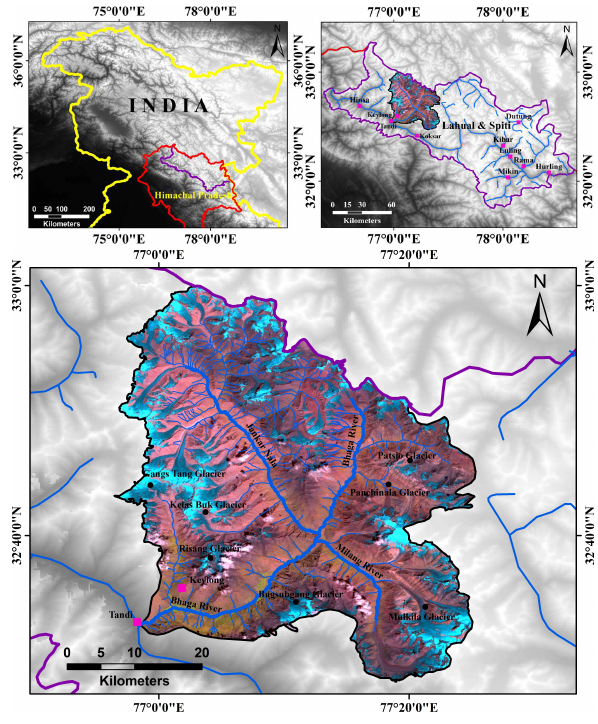
Figure 1: Location Map Of Study Area